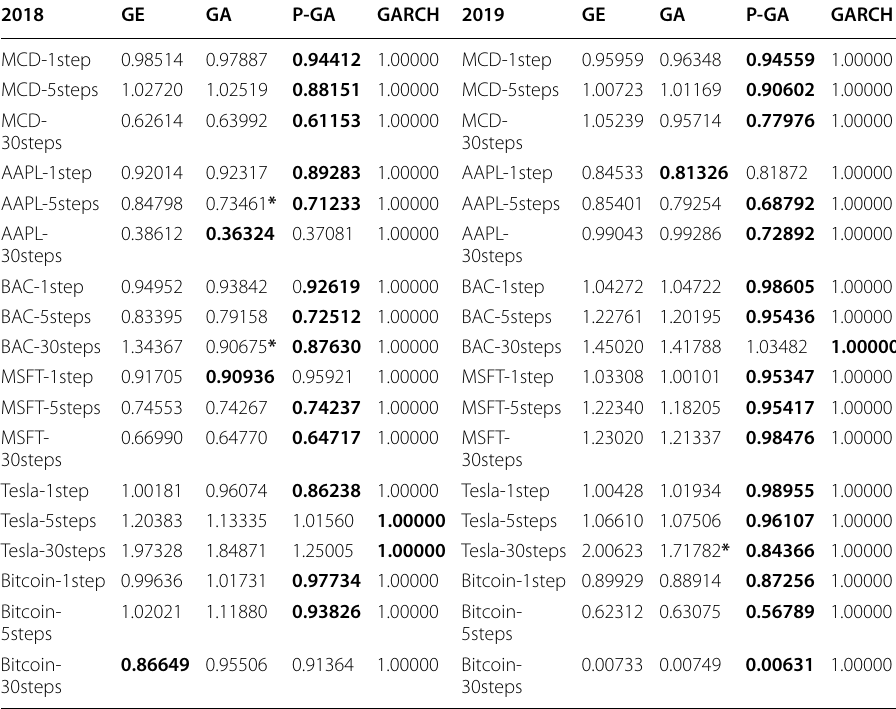
Column names “GA” and “GE” represent GE-NoVaS and GA-NoVaS methods, respectively; “GARCH” means the GARCH-direct method; and “P-GA” means the P-GA-NoVaS method. The benchmark is the GARCH-direct method, so numerical values in the table corresponding to the GARCH-direct method are 1. Other numerical values are relative performance compared to the GARCH-direct method. The bold value indicates that the corresponding method is the optimal choice for this data case. Cell with indicate that the GA-NoVaS method is at least 10 % better than the GE-NoVaS method, or inversely, the GE-NoVaS ∗ method is at least 10 %